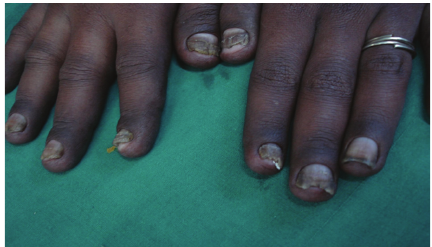
Figure 1: Onychodystrophy of finger nail.